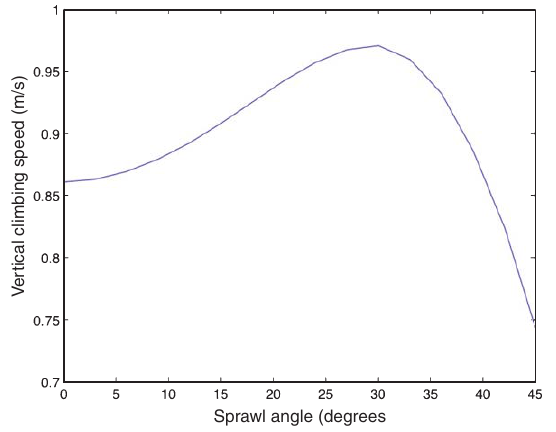
Fig. 7. Steady-state vertical climbing velocity plotted versus sprawl angle for the world-switched motor-powered climber. Note that a sprawl angle of roughly 30 ◦ maximizes vertical climbing